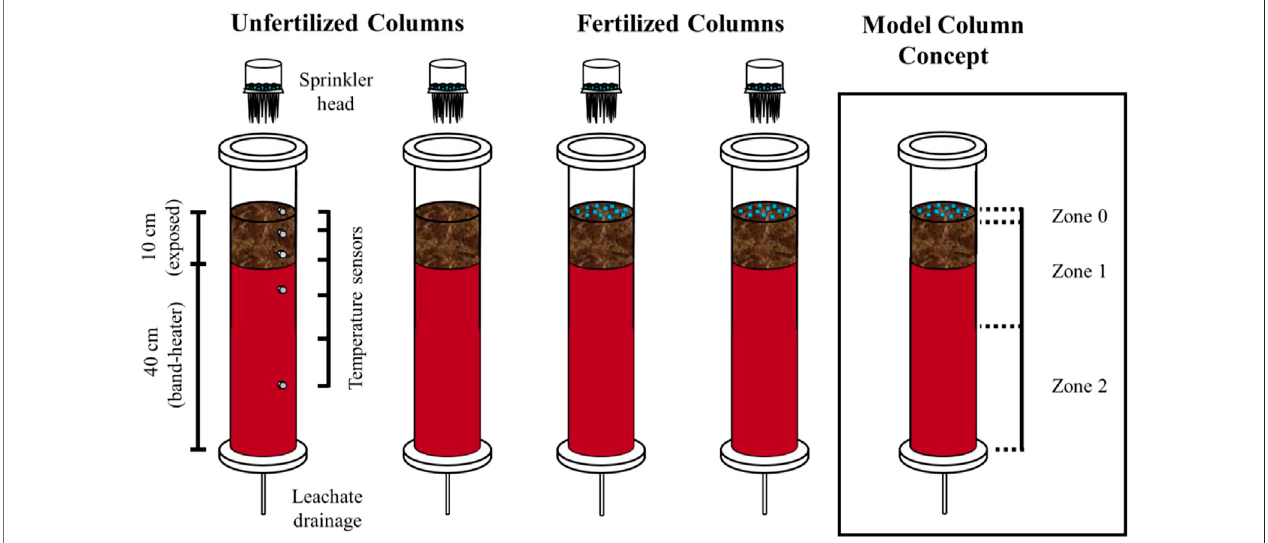
FIGURE1| Schematicshowingthe twocontrol columns (unfertilized) and twoexperimental columns (fertilized).Temperaturesensorswere installed at +2.5, − 3.5, − 7, − 15.5, and − 33 cm relative to the soil surface in one of the control columns. The column on the right is showing the concept used for the simple plug fl ow reactor model with three zones ( Section 2.6